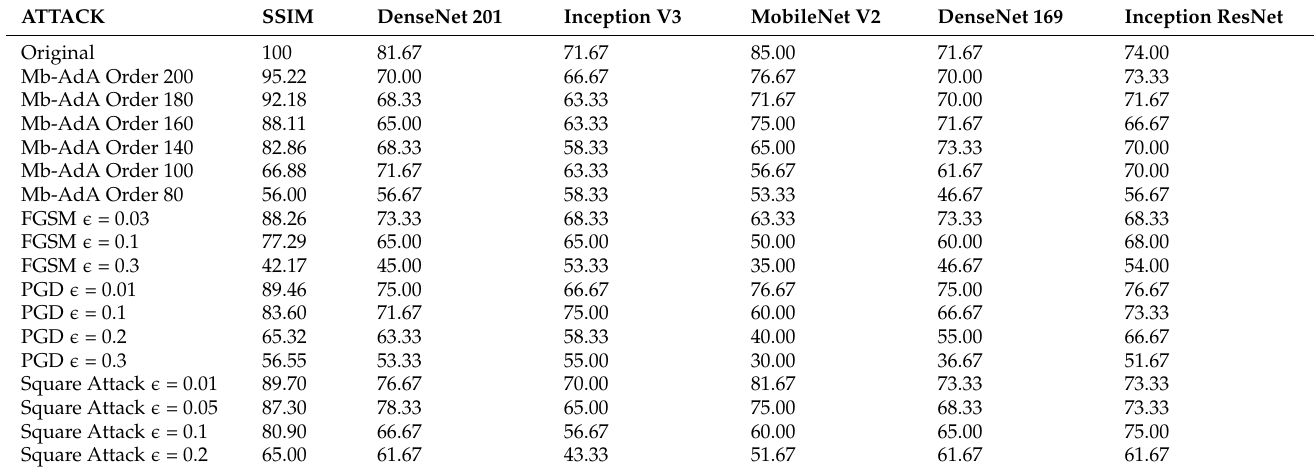
Table 2. Image quality and accuracy in histopathological images under attacks (in %).